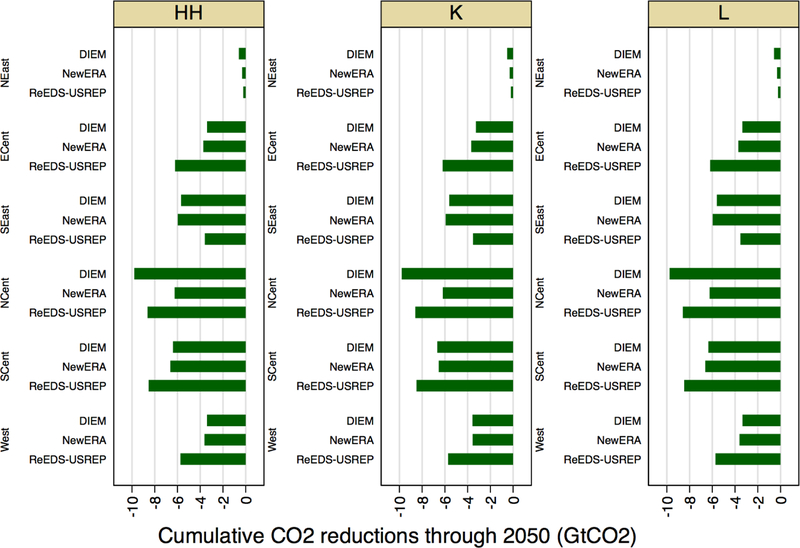
Cumulative CO2 reductions through 2050
(GtCO2) by region for a $25@5% tax.